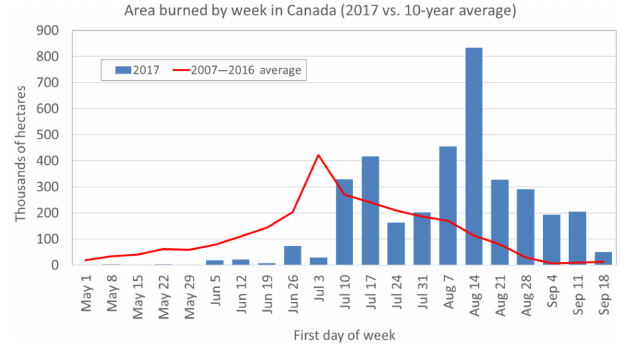
Figure 3. Locations of Canadian NAPS and US AQS stations used for 2017 model evaluation with 75% measurement completeness criteria. Some stations measure more than one species.